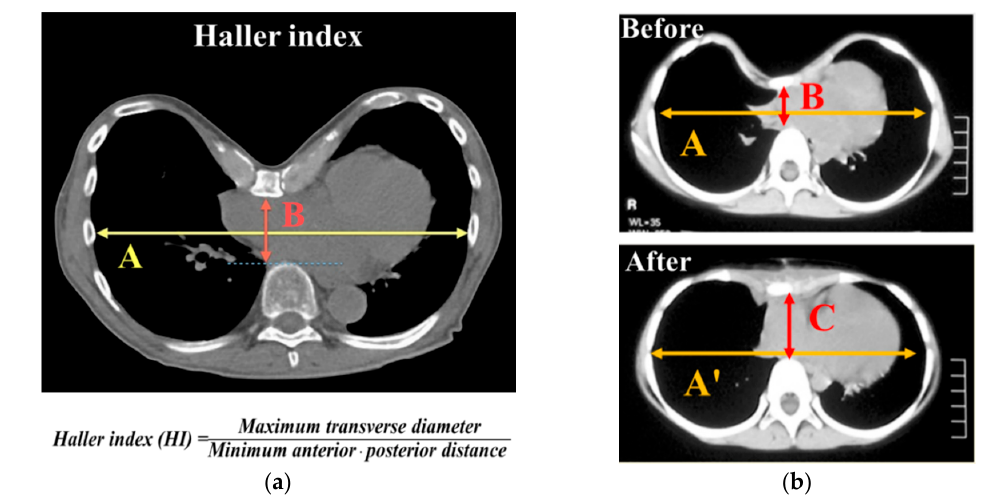
Figure 3. Illustration of pectus indices calculated from the computed tomography (CT) axial image with greatest sternum depression: ( a ) description of the Haller index; ( b ) measurement of the Haller index before and after the Nuss operation.